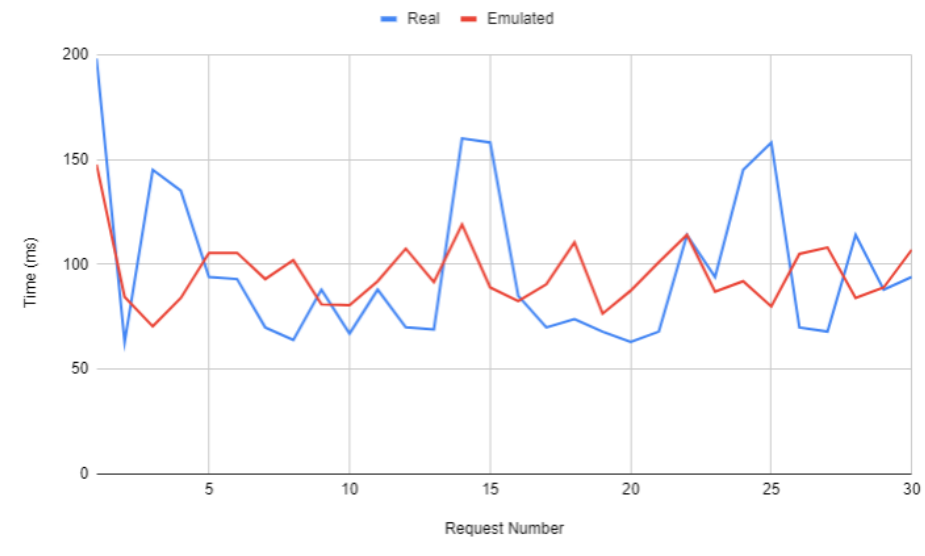
Figure 12. Response times for a real device vs an emulated